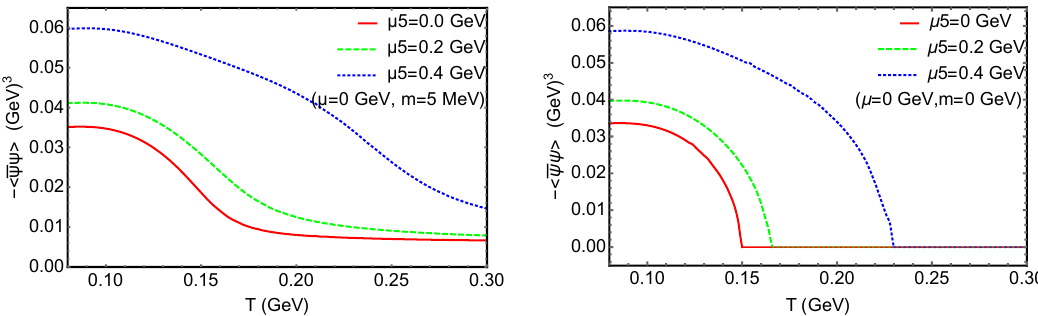
Figure 1 . The quark condensate from MT model at (cid:12)nite T with (cid:22) = 0 GeV and di(cid:11)erent (cid:22) 5 ’s.